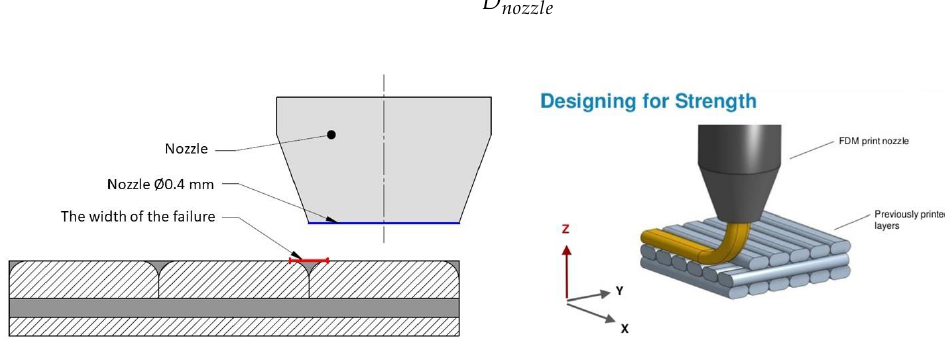
Figure 2. Definition of relative failure.